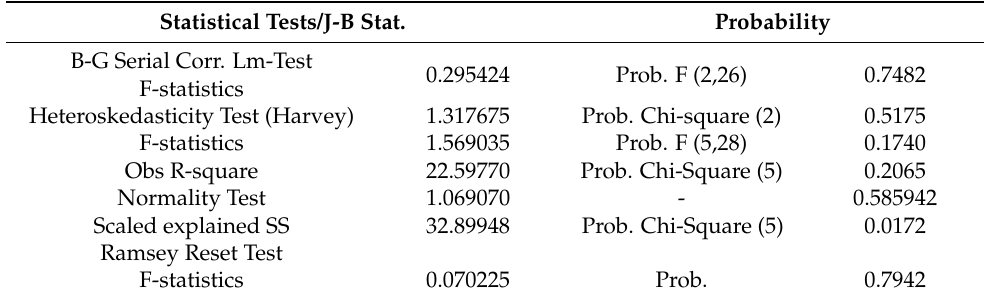
Table 7. Residual Diagnostic Checks.